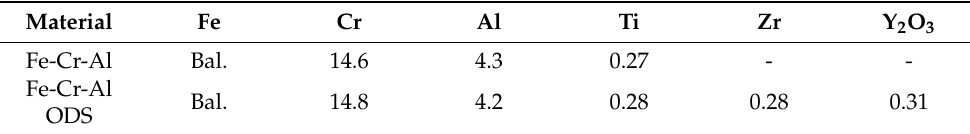
Table 1. The measured chemical compositions of the oxide dispersion strengthening (ODS) alloys